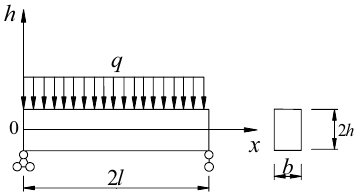
Figure 1. Roof beam model of rectangular